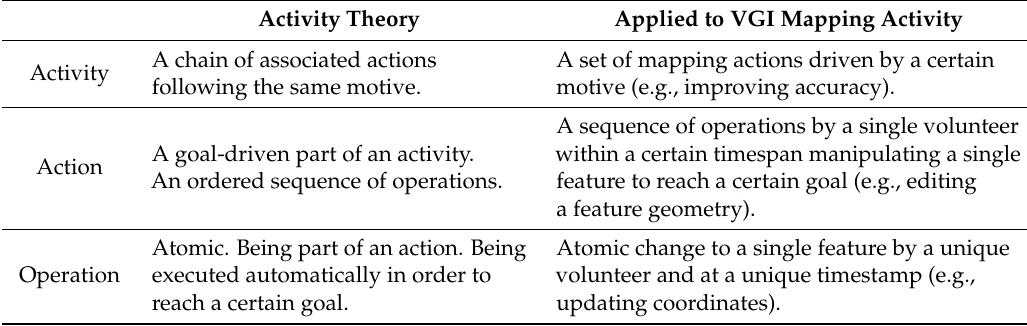
Table 2. Concepts of Activity Theory applied to VGI mapping activities